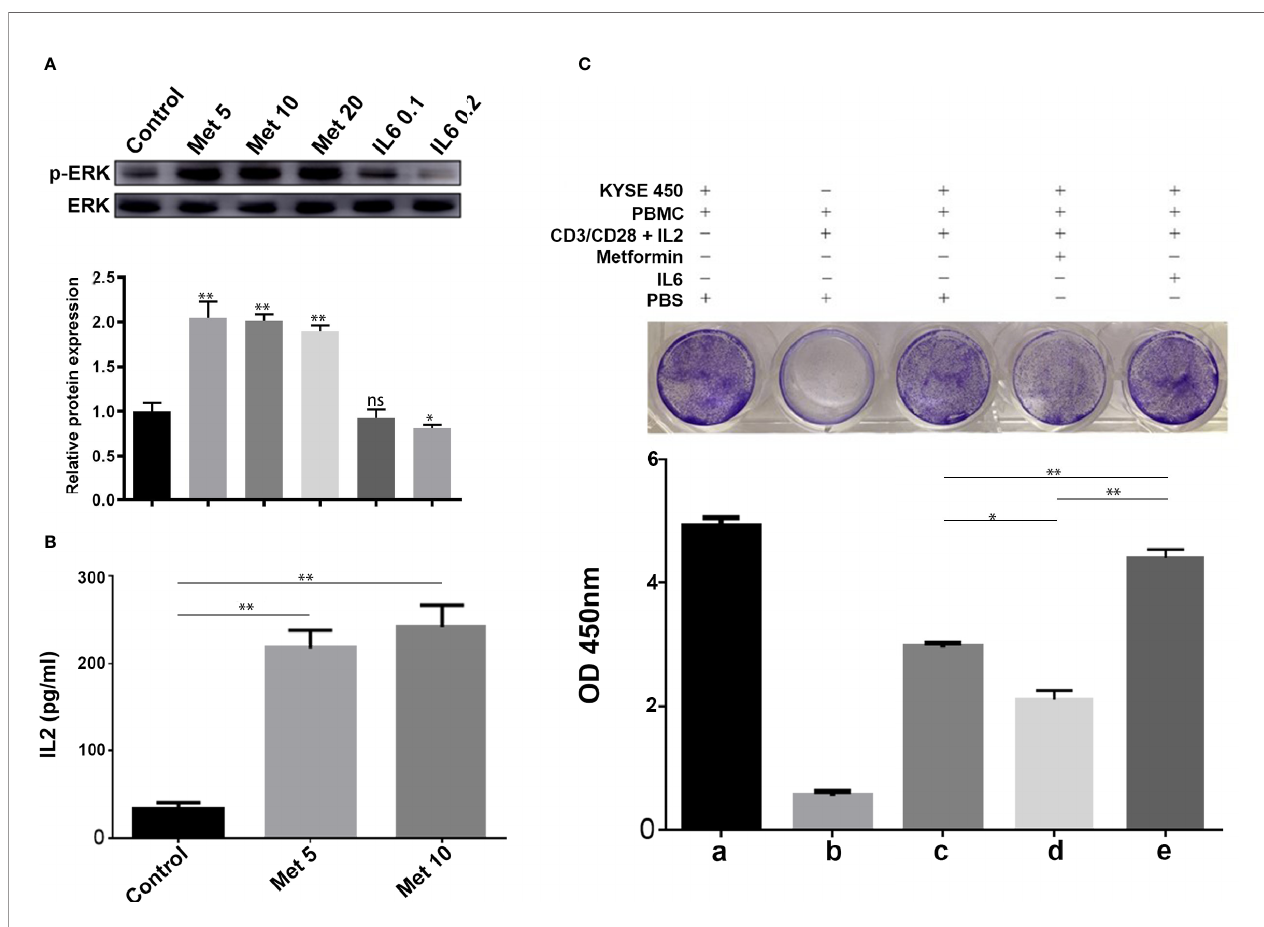
FIGURE 5 | Metformin increases T cell activity through the IL-6/PD-L1 axis. (A) ERK phosphorylation was determined by Western blotting (quanti fi cation of p-ERK expression level shown at the bottom. (B) IL-2 secretion was measured using a human IL-2 ELISA kit. (C) T-cell-meditated tumor cell-killing assay in KYSE-450 cells incubated with metformin, IL6, or PBS, and a-e were the quantitative results of the above grouping. Data represent the mean ± SD of three independent experiments. *p < 0.05, **p < 0.01, ns, no signi fi